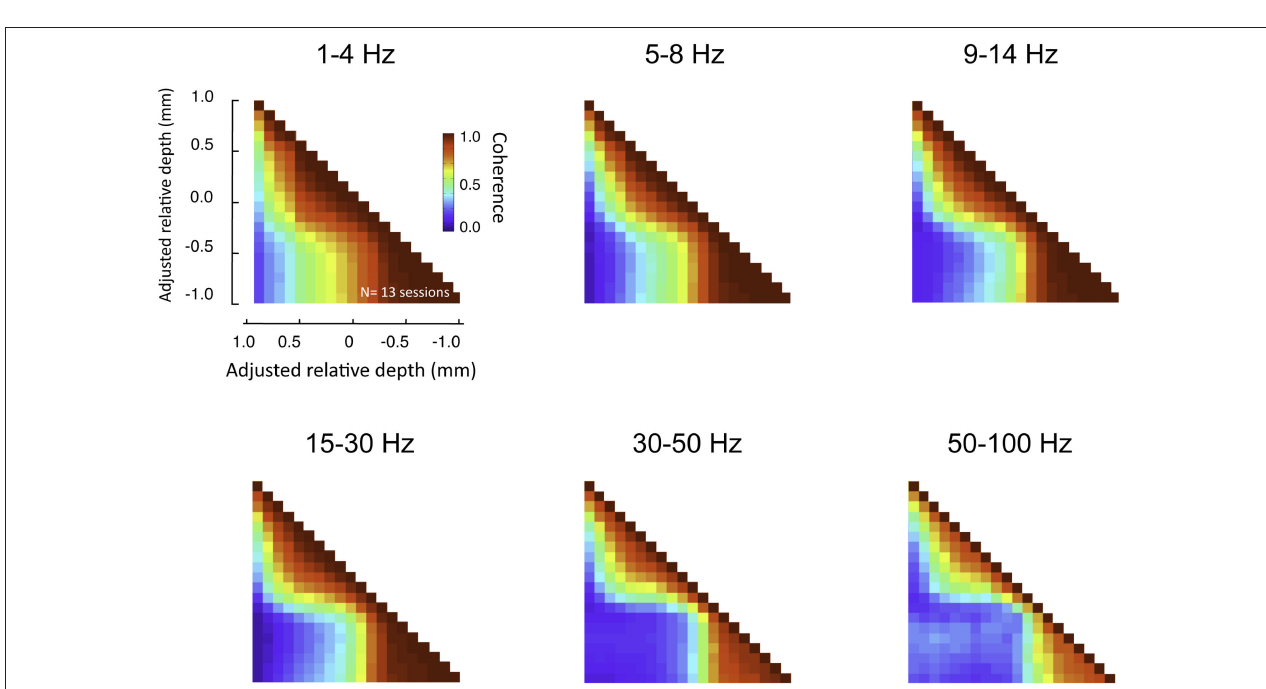
Figure 5 | Pair-wise coherence of all sessions in the gamma-range. (A) Average CSD to flashing screen following alignment to initial sink. (B) Mean gamma-range coherence, computed between all pairs of laminar positions over